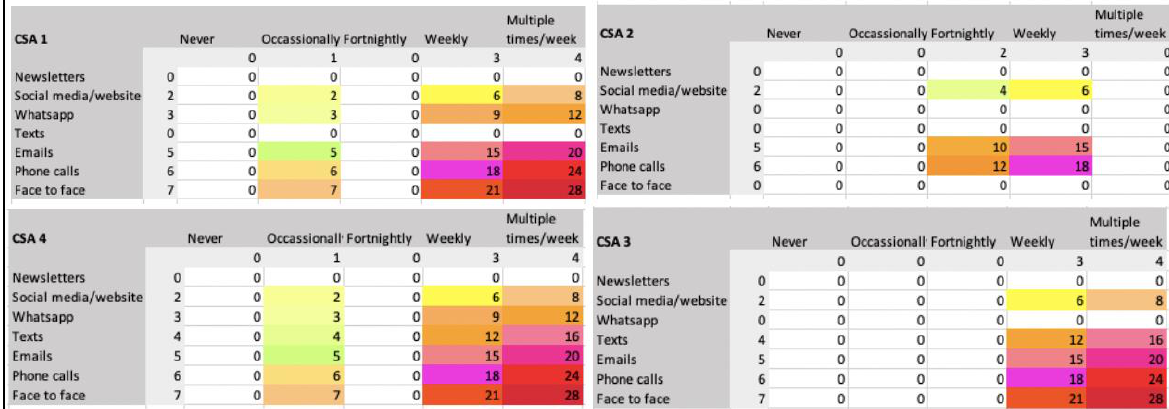
Figure 2. Bridging and Bonding Social Capital Across the Four Case Studies